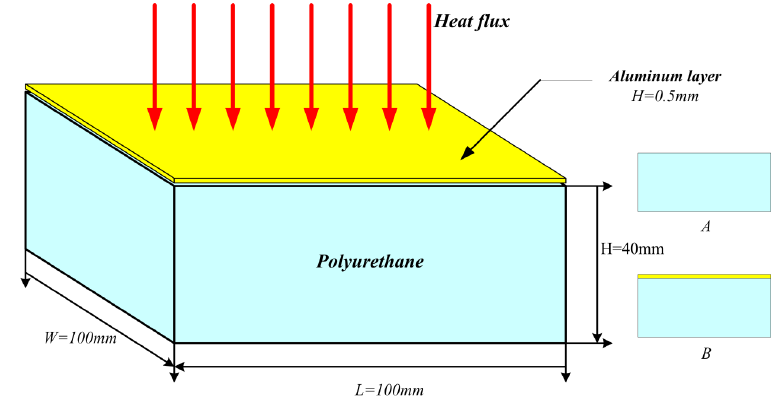
Figure 1. The structure of aluminum ‐ polyurethane and pure polyurethane.